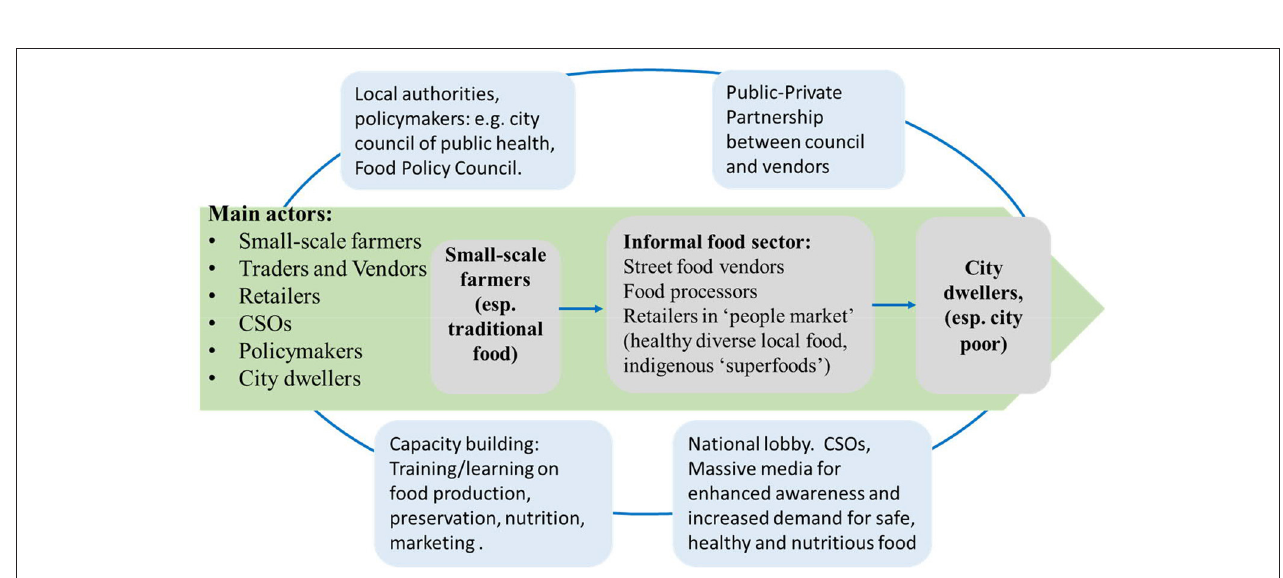
FIGURE 3 | The status quo of informal food sector in diets and nutrition chain in Lusaka.